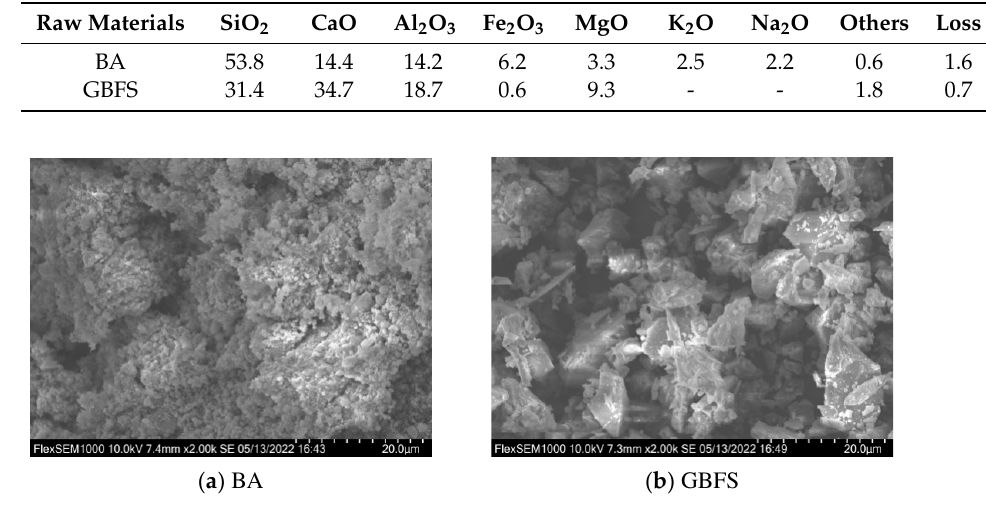
Figure 1. Micromorphology of BA and GBFS